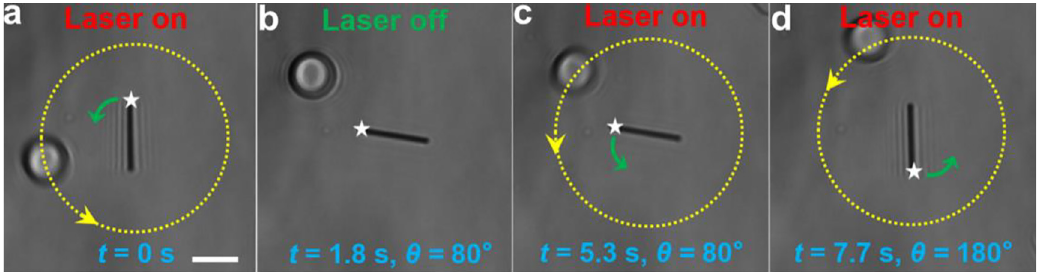
Figure 3: Microsphere-assisted orientation of the Ag nanowire. The scale bar is 10 μ